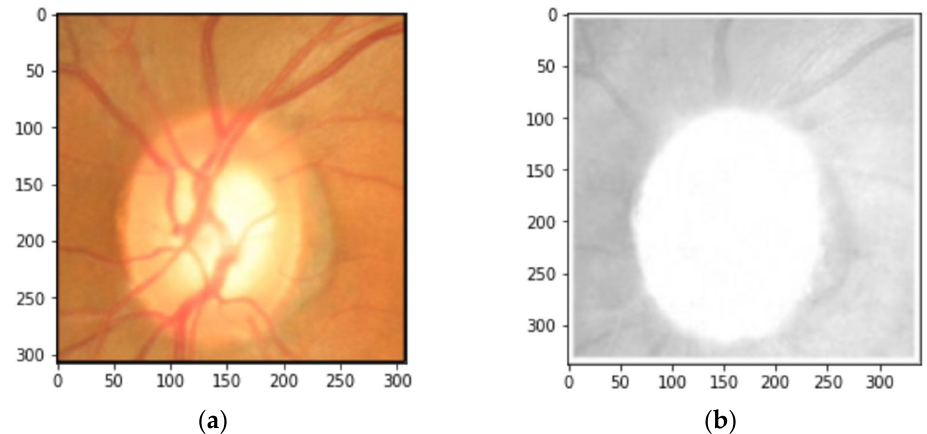
Figure 9. Red channel extraction. RoI before the extraction ( a ) and the RoI after the extraction leaving only a red channel on the image ( b ).